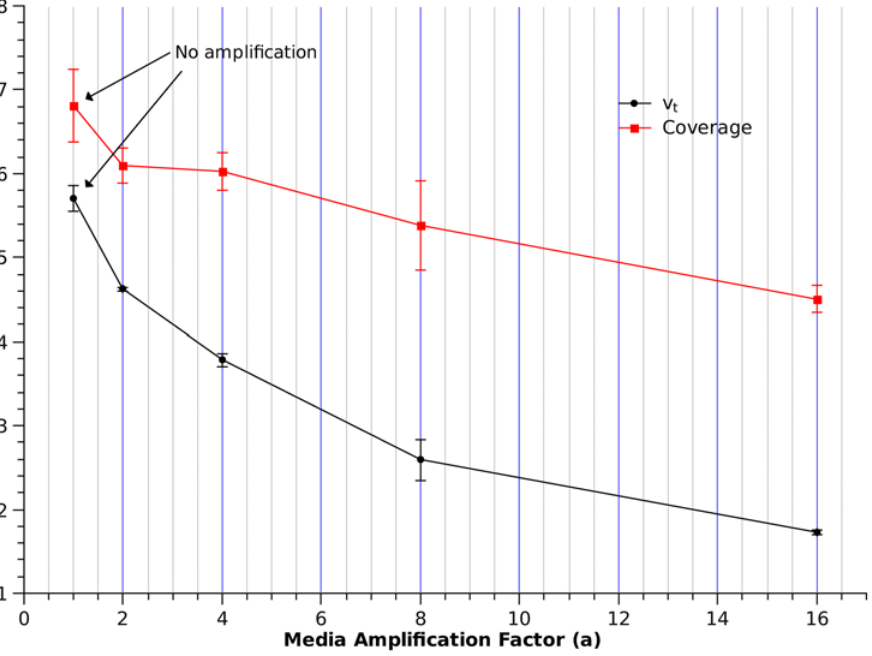
Figure 4. Effect of media amplification factor on vaccination coverage and willingness to vaccinate. Coverage and v t values are averages and standard deviations over the population values in the last week of simulation.